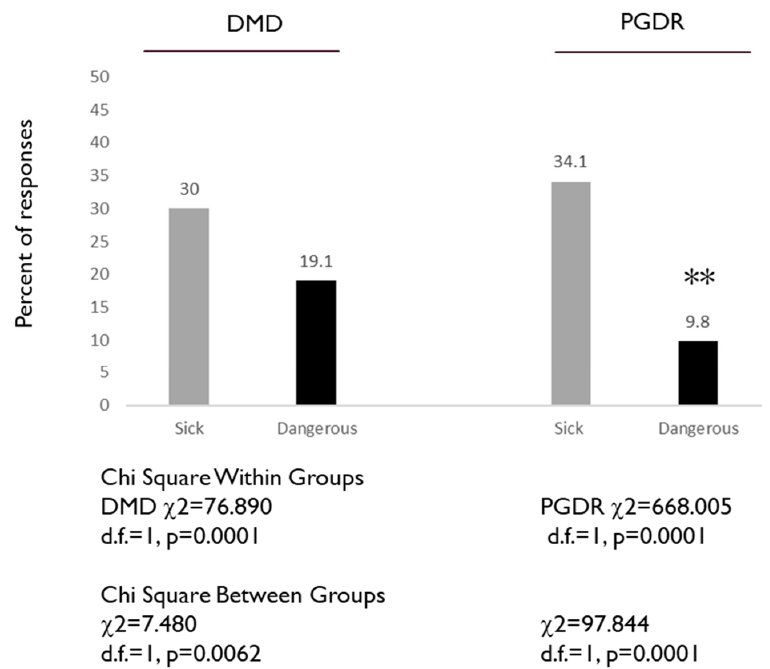
Figure 2. Assessment of DMD and PGDR responses to specific questions: Vaccines can make you sick, and some vaccines are dangerous. DMD students exhibited significantly higher percentages of agreeing that some vaccines are dangerous (19.1%) versus PGDR (9.8%) p = 0.0001, while responses to vaccines can make you sick were similar (30.0% versus 34.1%). Note: ** indicates statistically significant differences.